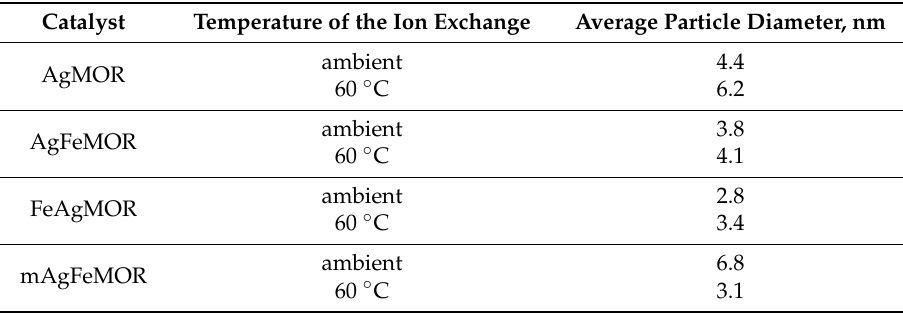
Table 4. Average diameters of silver particles of the studied mordenite-based